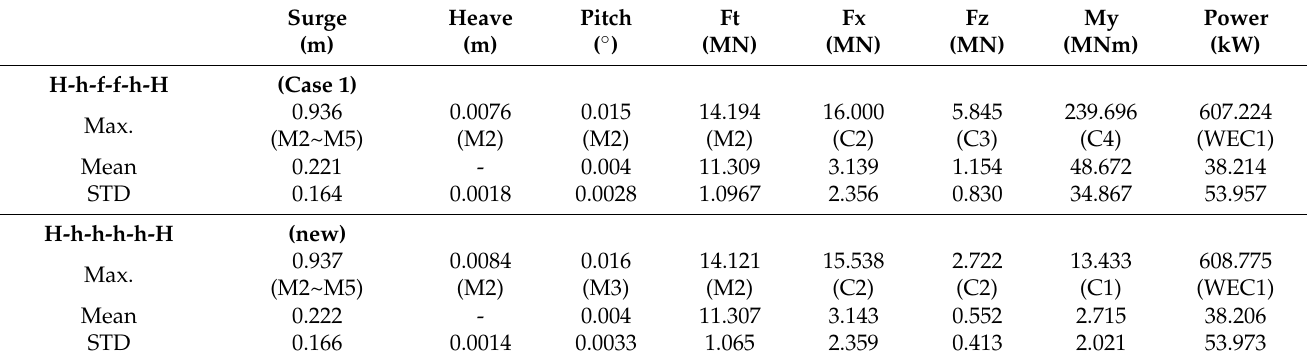
Table 3. Main extreme responses of the two representative MFS